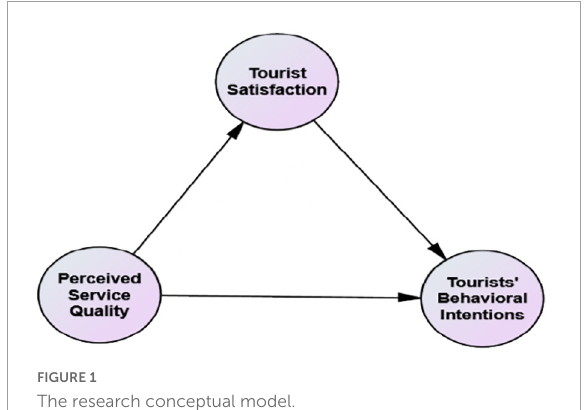
FIGURE1 The research conceptual